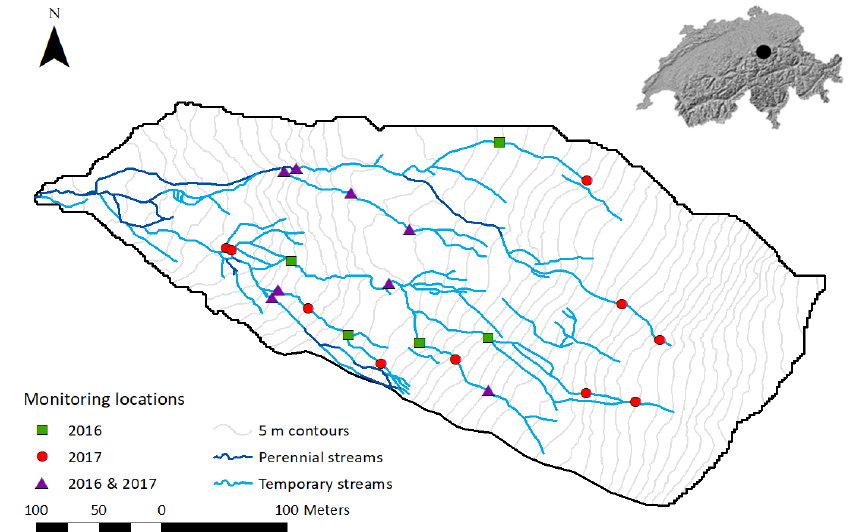
Figure 10. Map of the field test site, including all field-mapped streams and the monitoring locations, where the multi-sensor monitoring system and time-lapse cameras were installed. Some locations were used exclusively during the 2016 field season (green squares) or the 2017 field season (red circles), the others were used during both seasons (purple triangles). The inset map indicates the location of the field test site (black dot) within Switzerland.